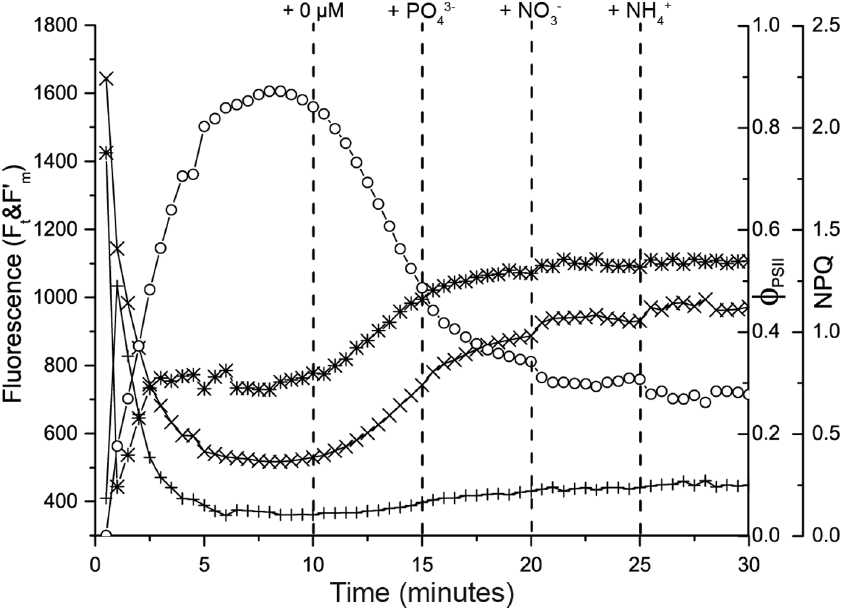
Figure 7. Typical NIFT response of Thalassiatestudinum . Example of the NIFT response of a T. testudinum leaf collected at Boka Ascension. The graph shows the time courses of steady-state fluorescence, F t ( + ); maximum fluorescence, F 9 m ( 6 ); the quantum yield of photosystem II, W PSII (); and non-photochemical quenching, NPQ ( # ). Vertical dashed lines indicate the timing of the control addition (0 m M) and the sequential addition of different nutrients (all at 100 m M).